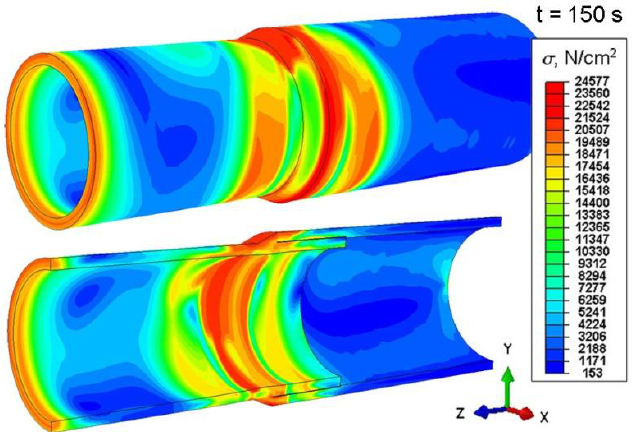
Figure 19. Reduced stresses after welding, for time t = 150 s.